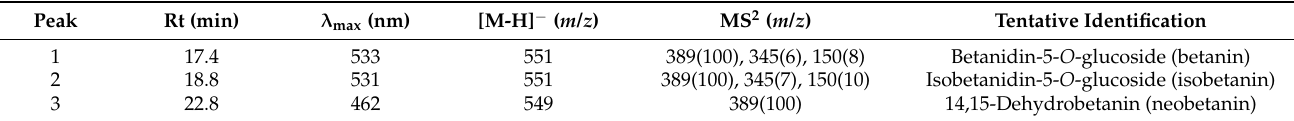
Table 1. Betacyanins identified in the beetroot powder sample. The retention time (Rt), wavelength of maximum absorption in the visible region ( λ max ), and mass spectral data are presented.